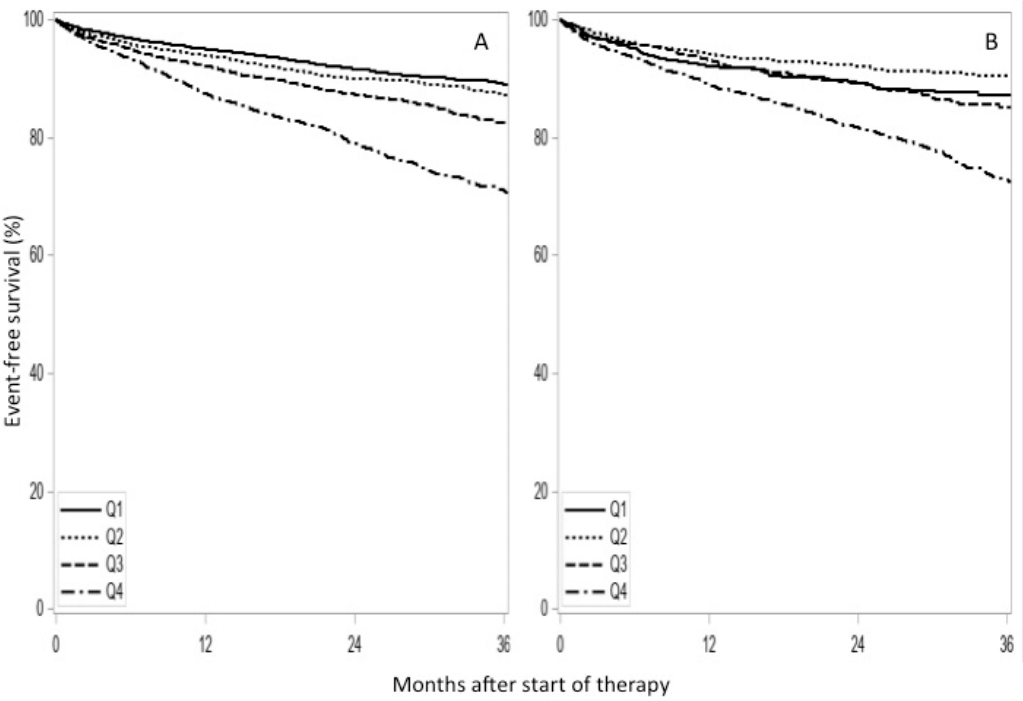
Figure 3. Event-free survival (recurrence of ACS or death) for male ( A ) and female ( B ) patients treated with clopidogrel, prasugrel, or ticagrelor. Numbers at risk are indicated. Q1, Q2, Q3, and Q4 quartile groups comprise patients aged 18–55, 56–66, 67–76, and ≥ 77 years, respectively. p < 0.001 (log-rank test).